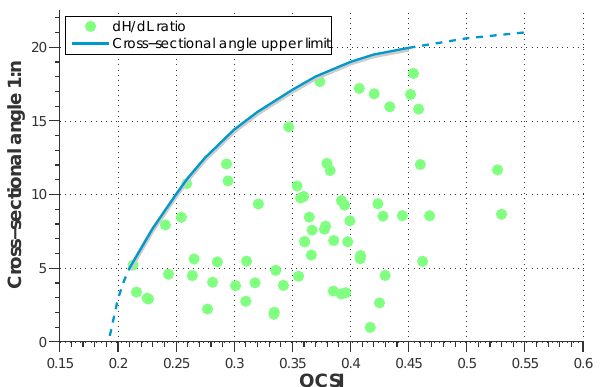
Figure 2. Relationship between the QCSI and the cross-sectional angle computed from a subsample of the landslide scarp data.